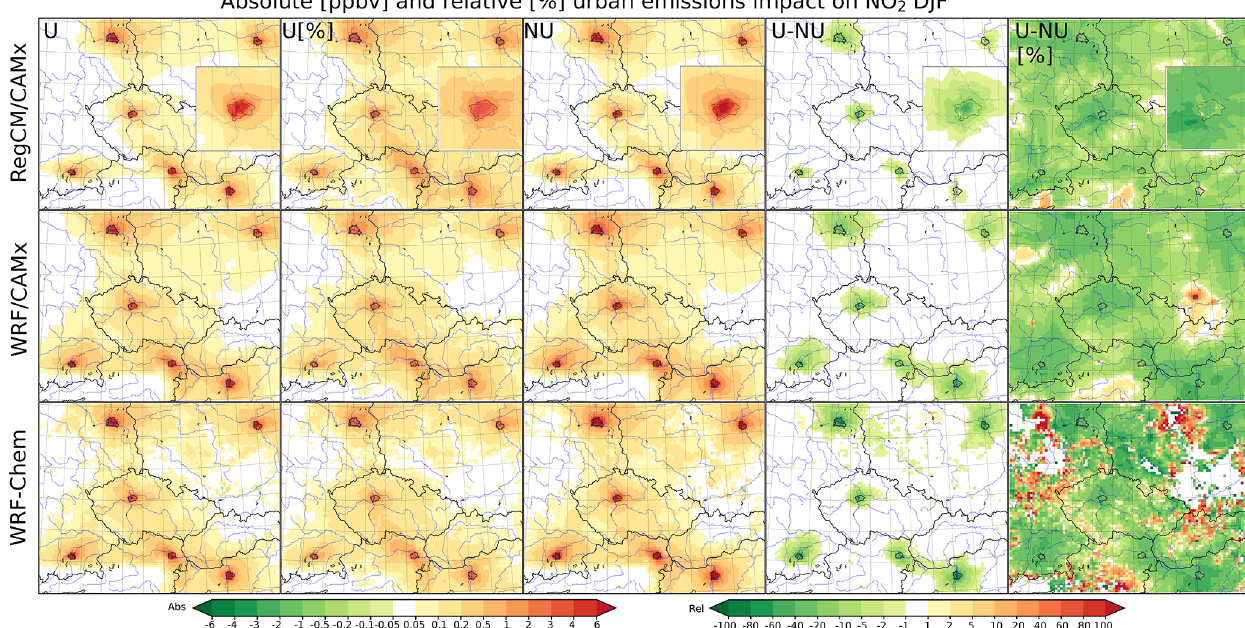
Figure 4. The urban emission impact (UEI) of six selected cities (Berlin, Budapest, Munich, Prague, Vienna and Warsaw) on average DJF near-surface NO 2 concentrations from 2015 to 2016 for the three modeling systems used: CAMx driven by RegCM (first row), CAMx driven by WRF-Chem meteorology (second row) and WRF-Chem (third row). Individual columns represent the UEI evaluated for the URBAN experiments as absolute (UEI URBAN ; U; in ppbv) and relative impact (UEI URBAN,rel ; U[%]), the UEI impact for the non-urbanized (NOURBAN) experiments (UEI NOURBAN ; NU), the difference between the two ( (cid:49) UEI; U-NU), and the relative change in the impact ( (cid:49)( UEI ) rel ; in %). The corresponding results for Prague at 1km resolution from the RegCM-driven CAMx experiments are plotted within the 9km figures in the upper row.